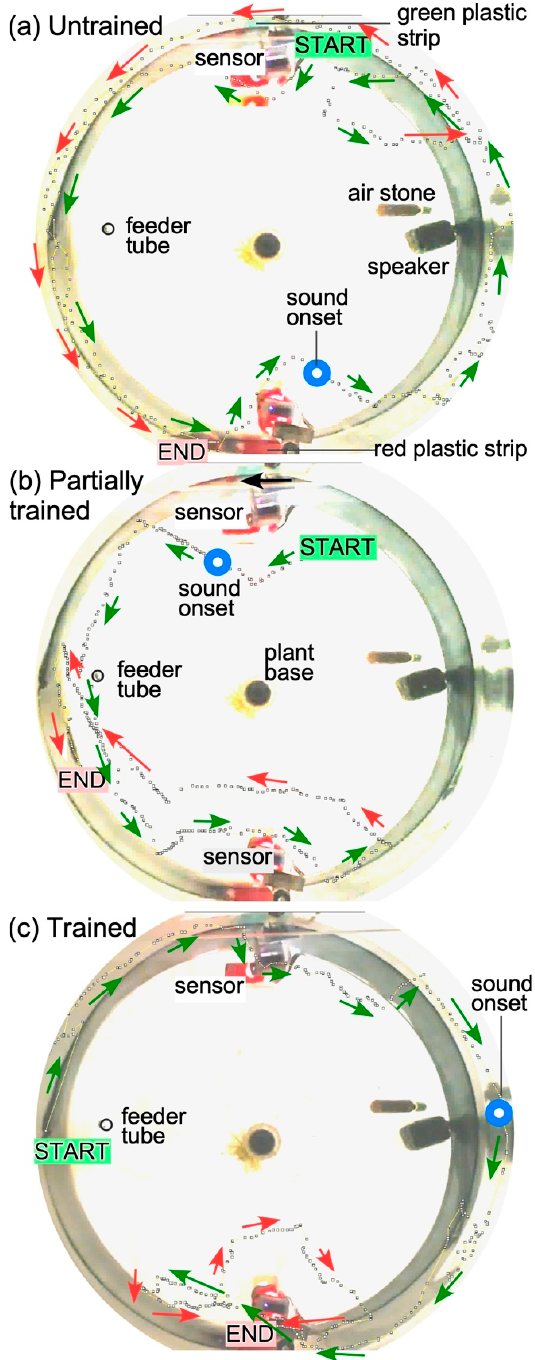
Figure 5. Progression of learning in a single zebrafish during operant conditioning. ( a ): Fish does not show any overt response to the presentation of a sound stimulus. ( b ). Fish shows awareness and attempts to trigger the sensor on the correct (red) side, but is unsuccessful. ( c ). Fish successfully triggers the sensor twice to receive a food reward. Dotted lines indicate the swimming path obtained from individual frames in the recorded video of the fish. A shortening of the distance between successive dots along the swim path indicates slowing down of the fish after hearing the sound. Blue circles indicate time point of sound onset superimposed on the fish’s swimming path. Arrows next to the trajectory indicate the heading of the fish. Green arrows indicate trajectory early in time and red arrows indicate trajectory later in time. Sensor activation/beam-disruption was indicated by a small LED flash on the sensor board that is reflected back in water (red rectangles in the